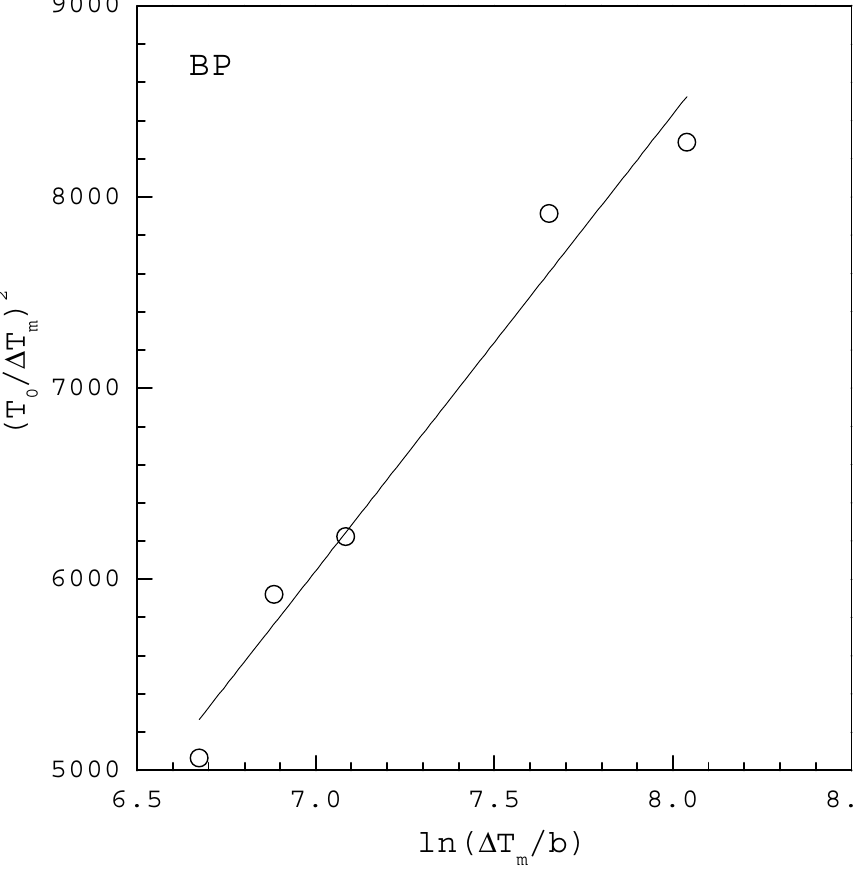
Figure 3. The MSZW data fitted to the linearized Equation (11) for BP in 5 mL ethanol saturated at T 0 = 313.15 K, where ∆ T m for each b is extracted at 50% of fraction detected nucleation events from the cumulative distributions of the MSZW data obtained by Yang [26].